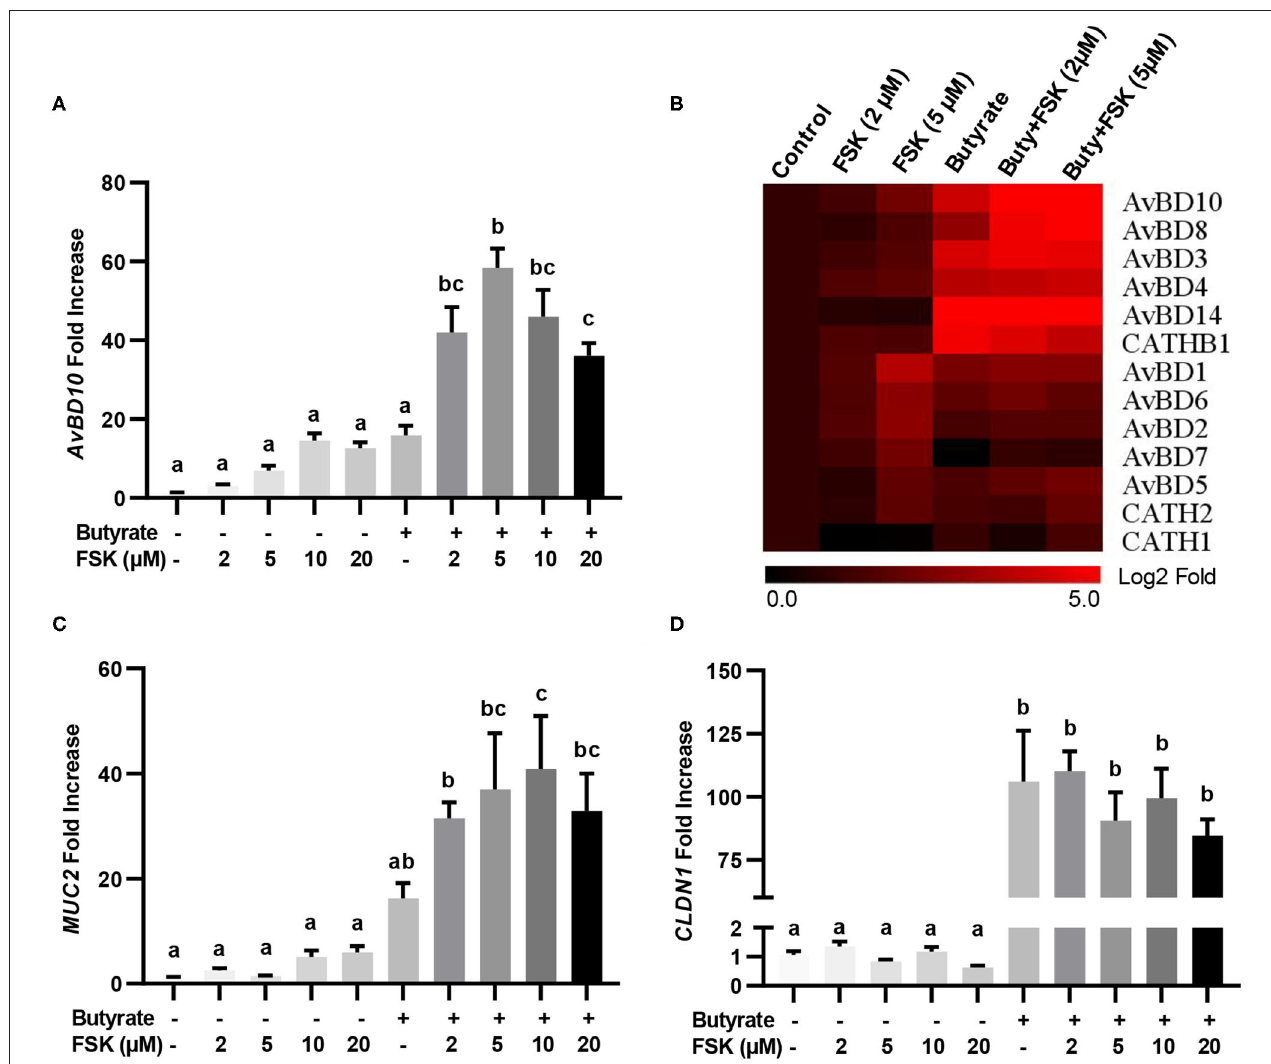
FIGURE 2 | Synergistic induction of HDP and barrier function genes in macrophages by butyrate and FSK. Chicken HD11 cells were stimulated in duplicate with 2mM butyrate and different concentrations of FSK individually or in combination for 24h, followed by RT-qPCR analysis of AvBD10 (A) , a panel of chicken HDP genes (B) , MUC2 (C) , and CLDN1 (D) . Fold changes in the heatmap were log 2 transformed. Results are shown as means ± SEM of three independent experiments. Statistical significance ( P < 0.05), denoted by non-common letters, was determined using one-way ANOVA and post-hoc Tukey’s